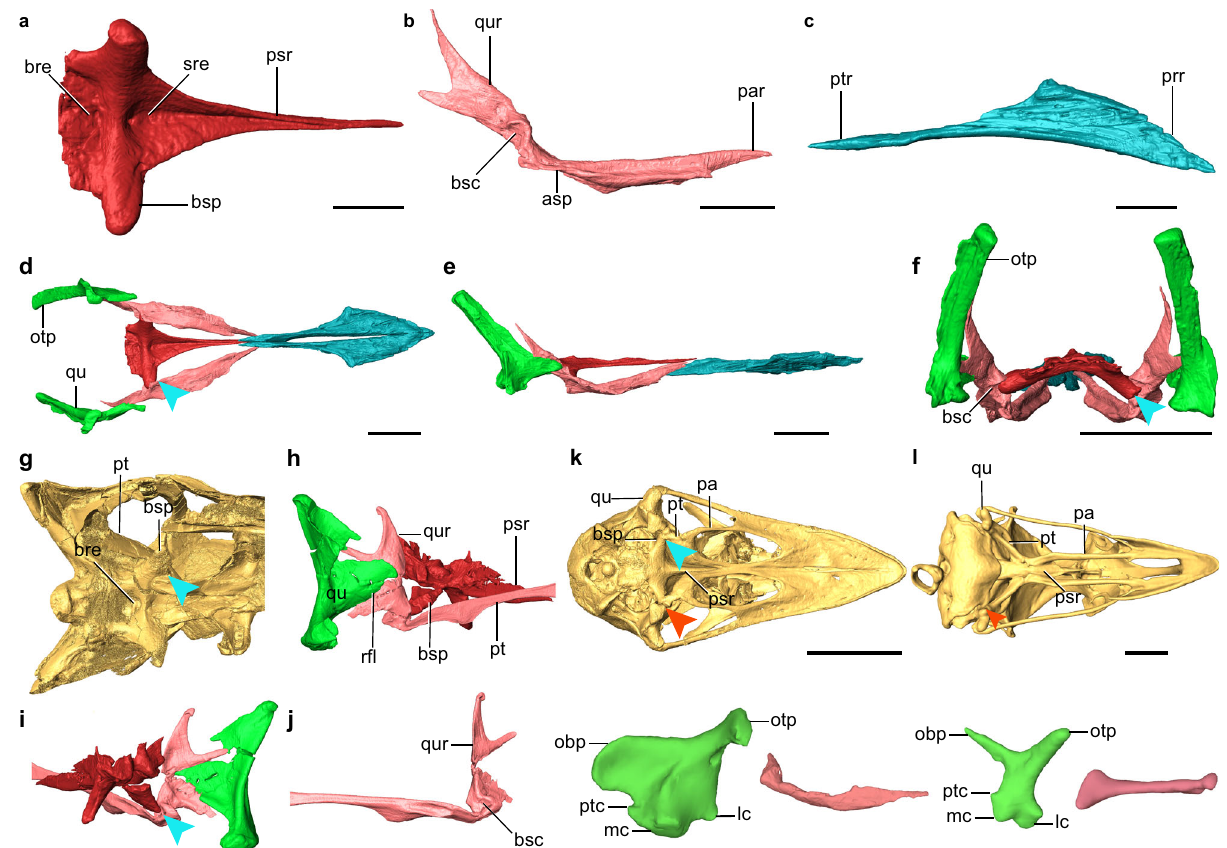
Fig. 3 Palatal complex comparison and primitive palate of IVPP V12707. a – f Digital reconstruction of palatal elements of IVPP V12707: Basisphenoid- parasphenoid (ventral view); b Left pterygoid (lateral view); c Right vomer (dorsal view); and reconstructed palatal complex in ventral ( d ), lateral ( e ), and caudal view ( f ). g – j Digital reconstruction of Linheraptor (Dromaeosauridae) braincase in ventral view ( h ), palate complex in craniolateral ( h ) and caudomedial view ( i ), and left pterygoid in medial view ( j ). k , l Dromaius novaehollandiae ( k ; Casuariiformes), and Tragopan caboti ( l ; Galliformes) in ventral view, with their left quadrate and palatine in lateral view. bre basisphenoid recess, bsc basipterygoid process cotyla, bsp basipterygoid process, mc medial condyle, qur quadrate ramus, par palatine ramus, prr premaxillary ramus, psr parasphenoid rostrum, ptc pterygoid condyle, ptr pterygoid ramus, r fl rostral fl ange, sre subsellar recess. Scale bars, 5 mm ( a – c ), 2 mm, ( d , e ), 1 mm ( f ), 50 mm ( k ), 10 mm ( l ). The blue arrows denote the ball-socket articulation between the pterygoid and basisphenoid. The red arrows denote the condylar-based articulation between the quadrate and pterygoid, a derived feature absent in nonavialan dinosaurs and the enantiornithine IVPP